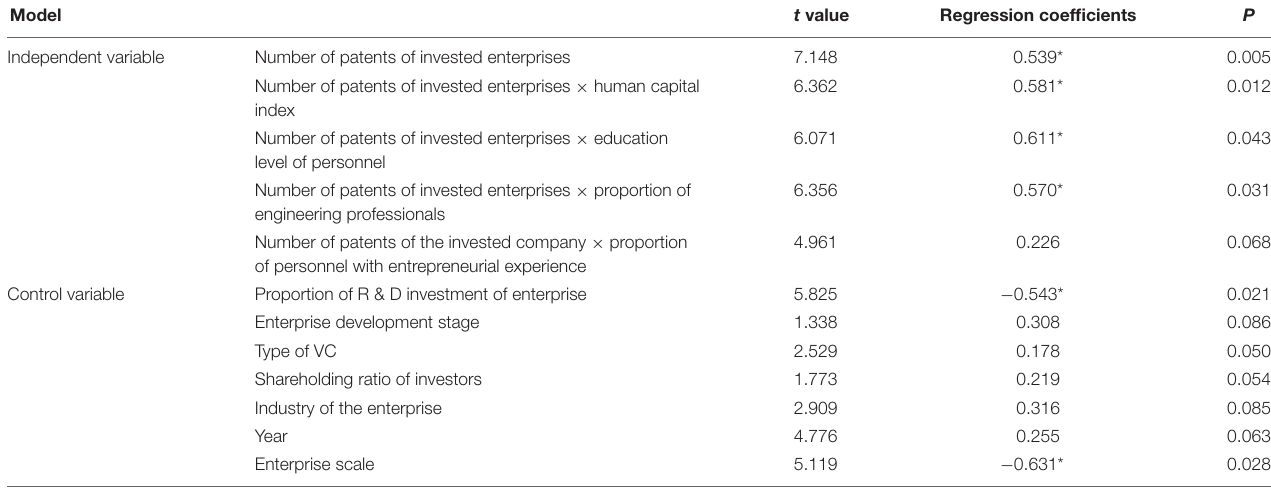
TABLE 7 | The role of human-capital VC in transforming enterprise’s innovation ability into enterprise’s benefit (Tobin’s Q ratio).